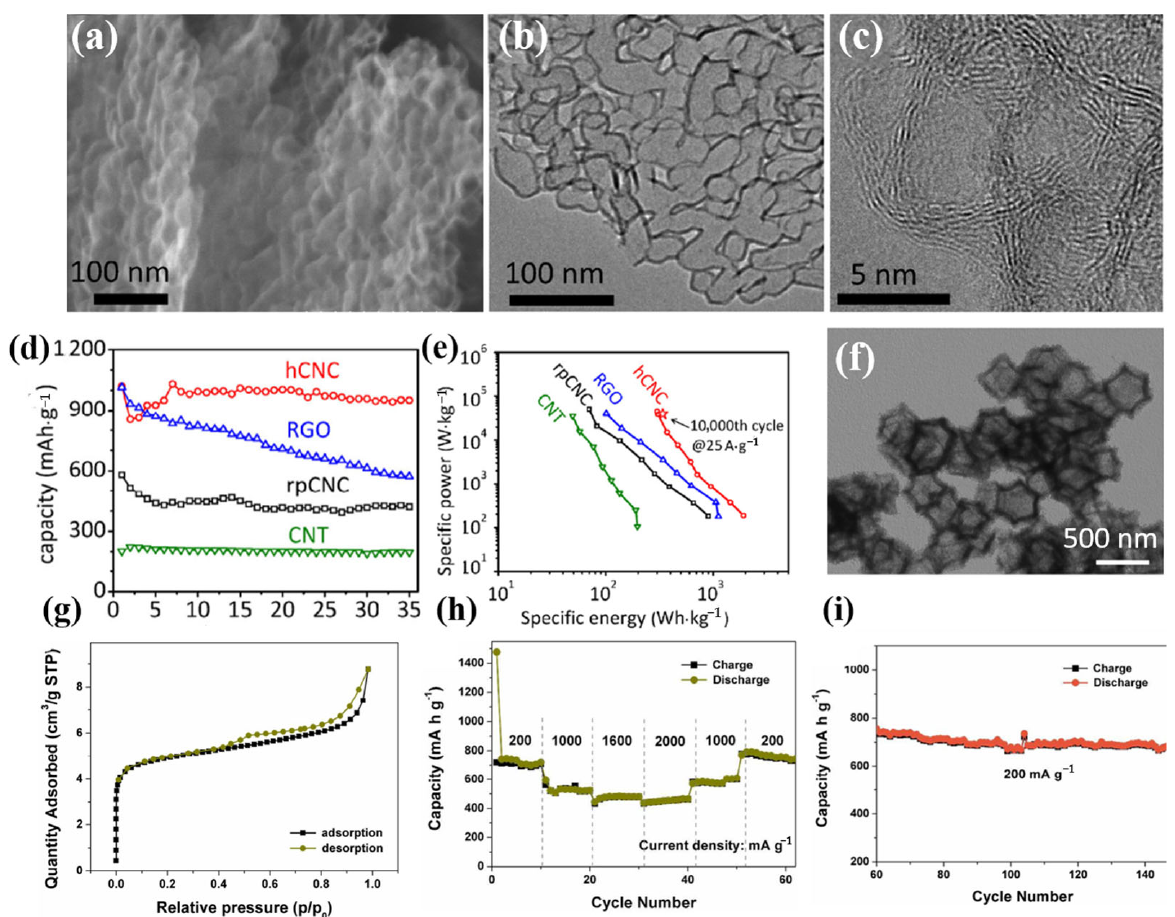
Figure 7. ( a ): SEM image. ( b ): TEM image. ( c ): High-resolution TEM image of the nanocages in ( b ) with well-graphitized layers in the shell. ( d ): The reversible capacities at the rate of 0.1 A g − 1 . ( e ): Ragone plot for the hCNC-based cell with lithium metal as the counter/reference electrode. The red pentagram represents the specific energy (339 Wh · kg electrode − 1 ) and specific power (37 kW · kg electrode − 1 ) for the hCNC after 10,000 cycles at the current density of 25 A · g − 1 . Comparison of Ragone plots for the hCNC and the rpCNC, CNT as well as RGO-based cells. ( a – e ) Reproduced with permission from [100]. ( f ): Low-magnification TEM image. ( g ): Nitrogen adsorption-desorption isotherms. ( h ): Rate performance at different current densities between 0.01 and 3.0 V. ( i ): Continued cycling performance of the porous Co-Zn/N-C polyhedral nanocage electrode (the same cell as for ( h )) over 80 cycles at 0.2 A g − 1 . ( f – i ) Reproduced with permission from [101].